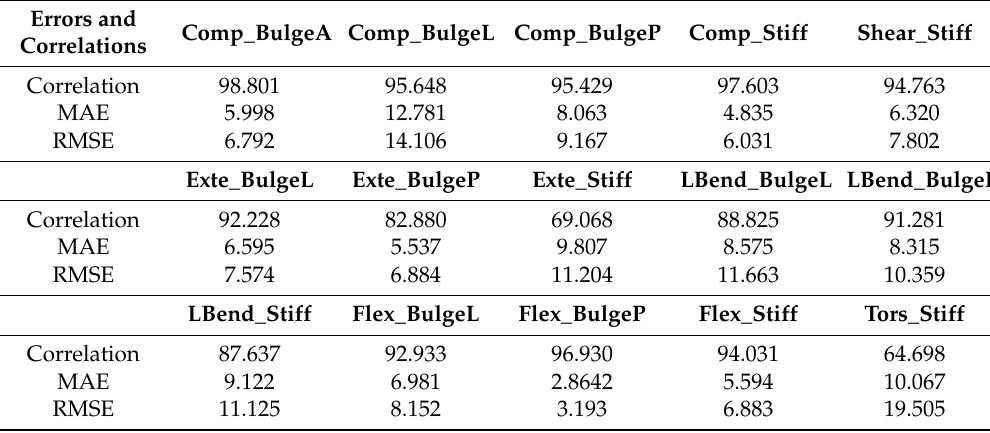
Table 27. Results of the predicted error criteria using the regression